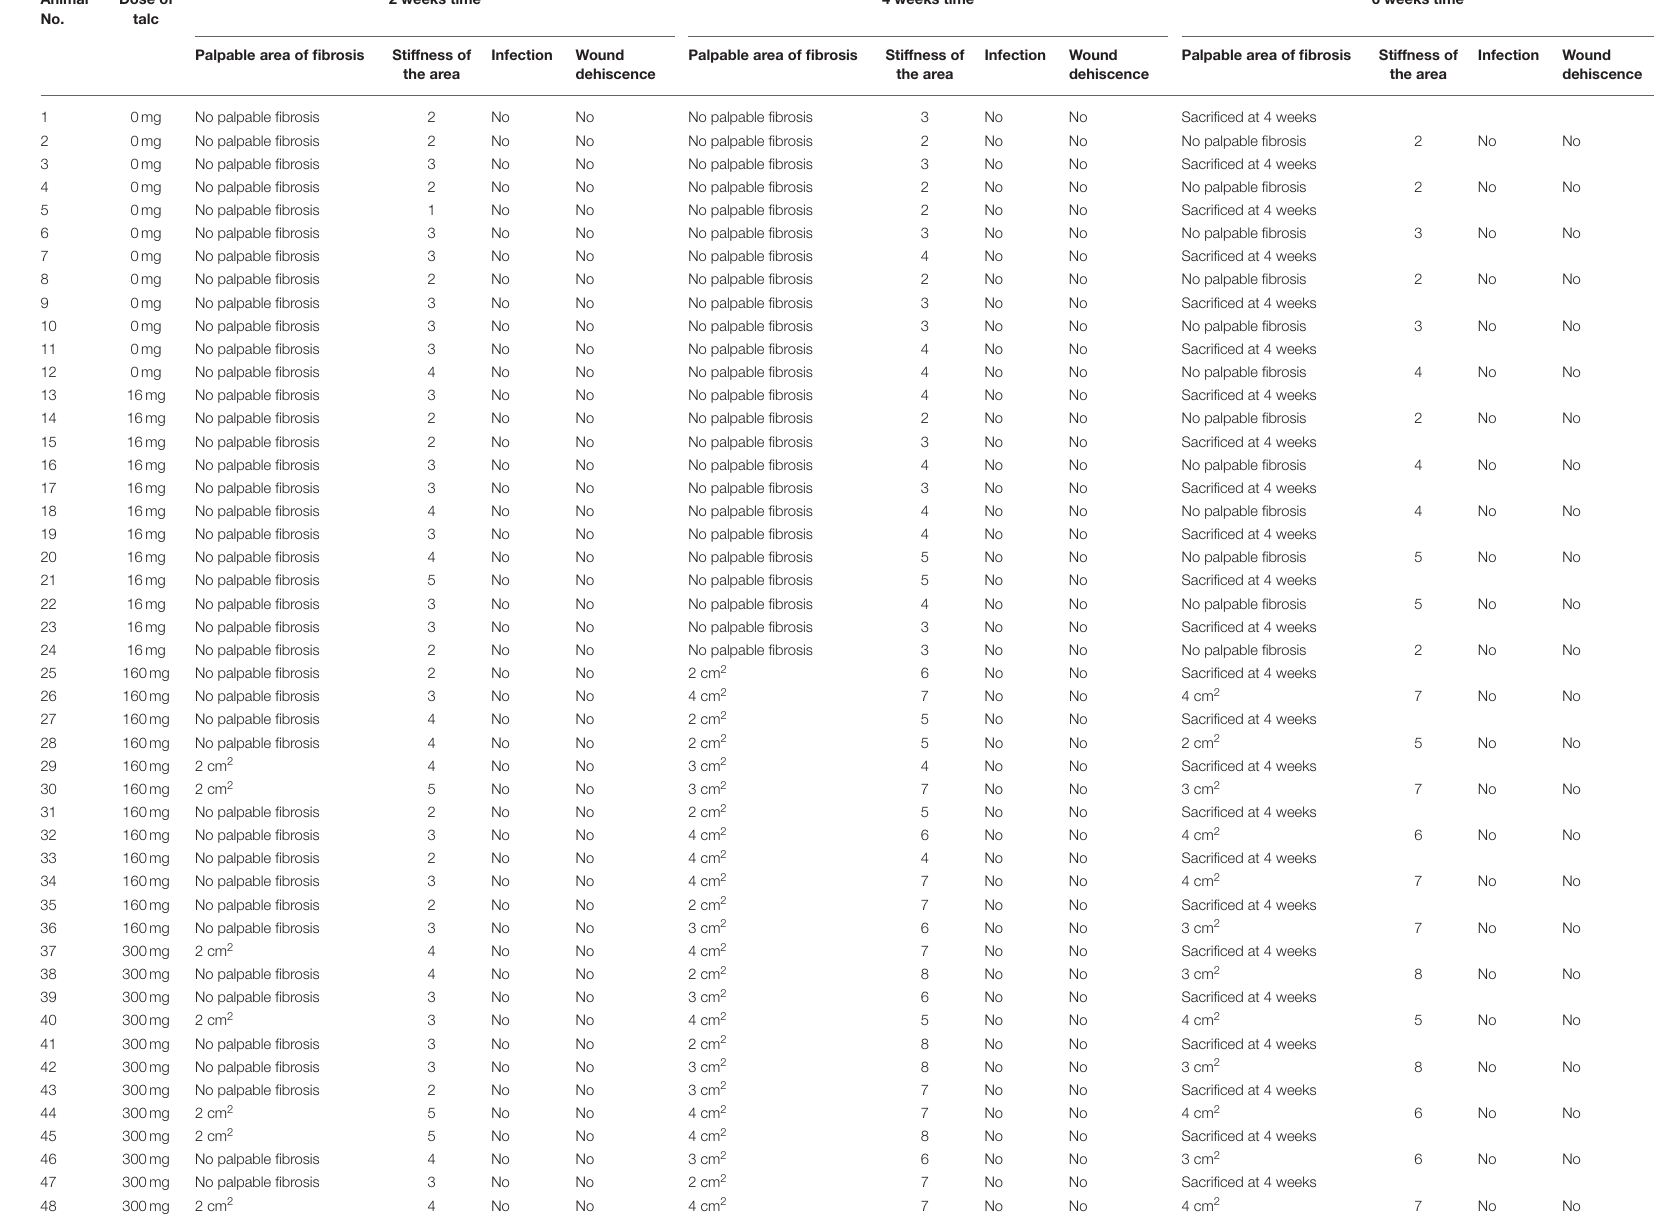
TABLE 1 | Gross examination. Animal